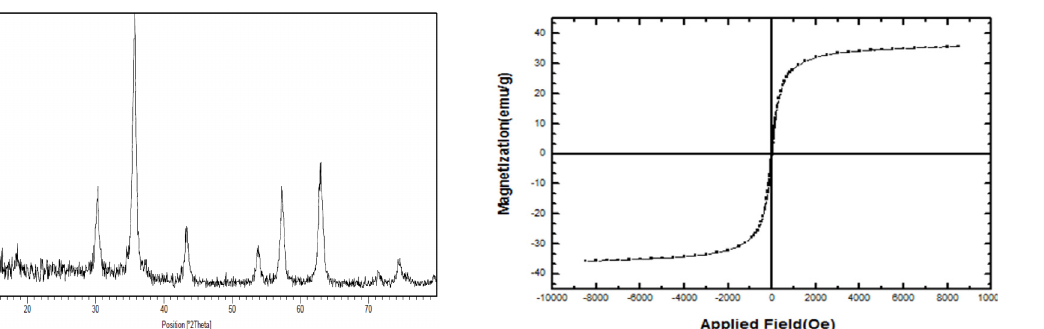
Fig. 1. XRD pattern of Fe